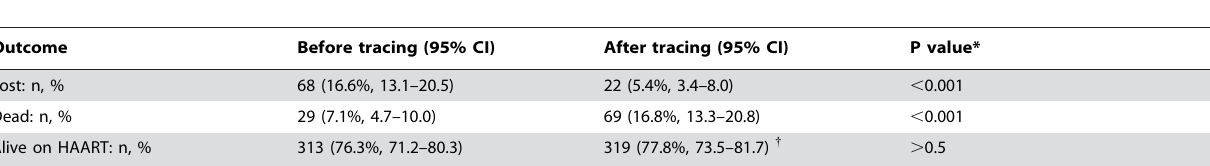
Table 2. Patient outcomes before and after tracing in the Infectious Disease Care Clinic, Gaborone, Botswana.